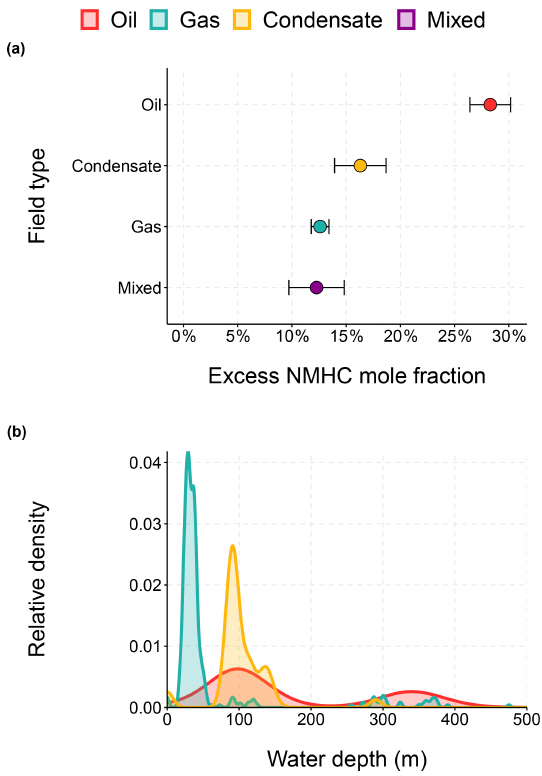
Figure 7. (a) Mean excess mole fraction for each offshore field type. Error bars represent 1 standard error. (b) Smoothed density distribu- tion of water depth obtained for each offshore field in the North Sea, coloured by field type. A depth of 305m (1000ft) defines deepwa-